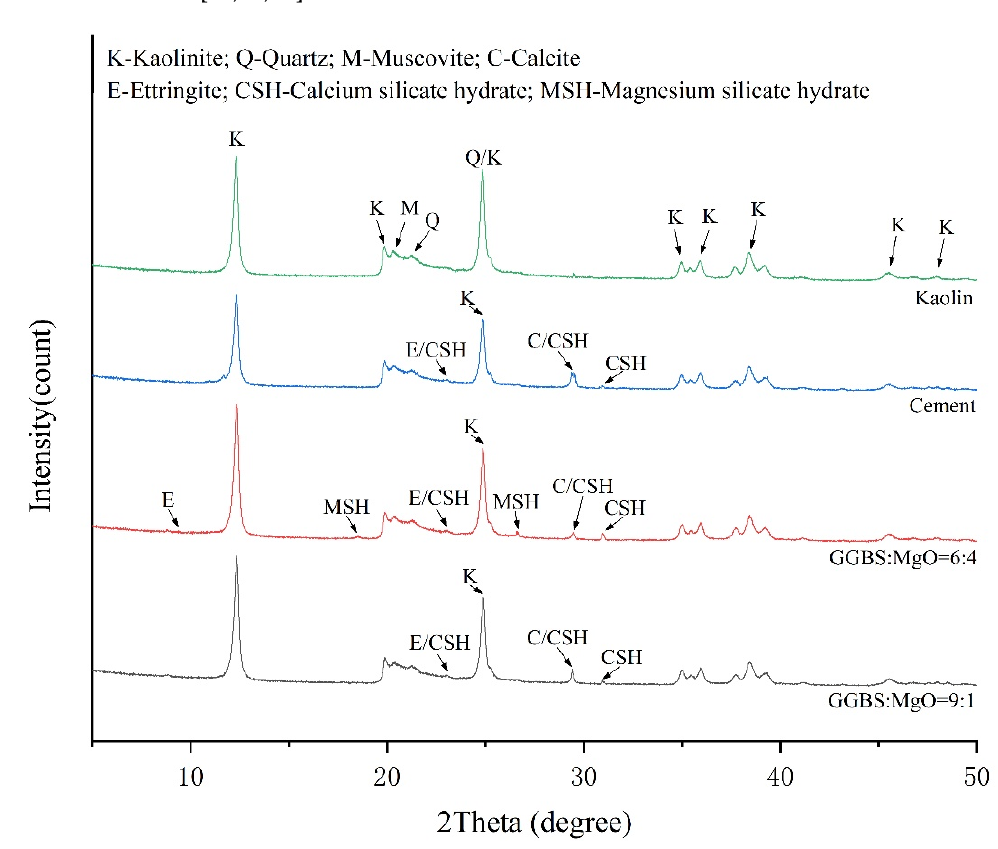
Figure 8. XRD patterns of kaolin and Ca-sulfate-soils treated with cement, GGBS:MgO = 6:4, and 9:1 after soaking.